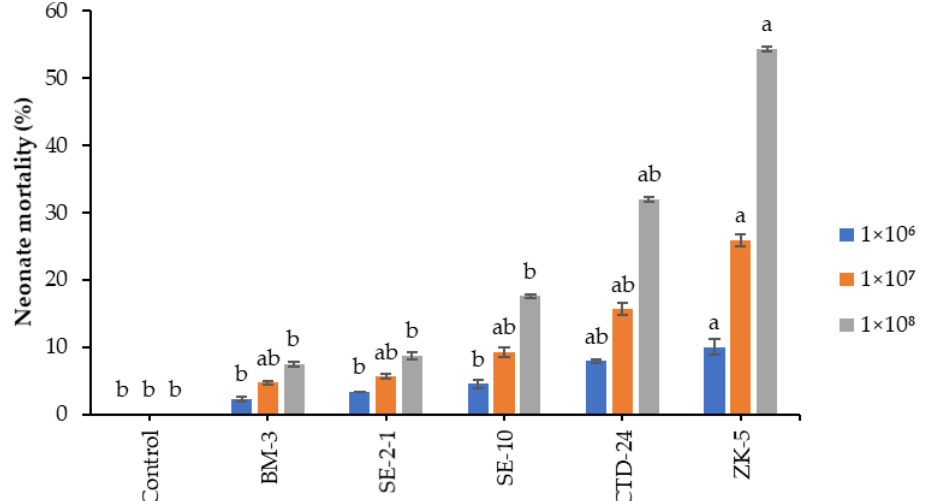
Figure 2. Fungal isolates, i.e., Aspergillus sp. BM-3 and SE-2-1, C. tenuissimum SE-10, P. citrinum CTD-24, and B. bassiana ZK-5-induced mortalities of the newly emerged S. frugiperda larvae. Means followed by the same letters are not significantly different at p < 0.05 using Tukey’s test. Table 4. Effects of fungal isolates on cumulative mortalities of eggs and neonates at 1 × 10 6 conidia mL − 1 .